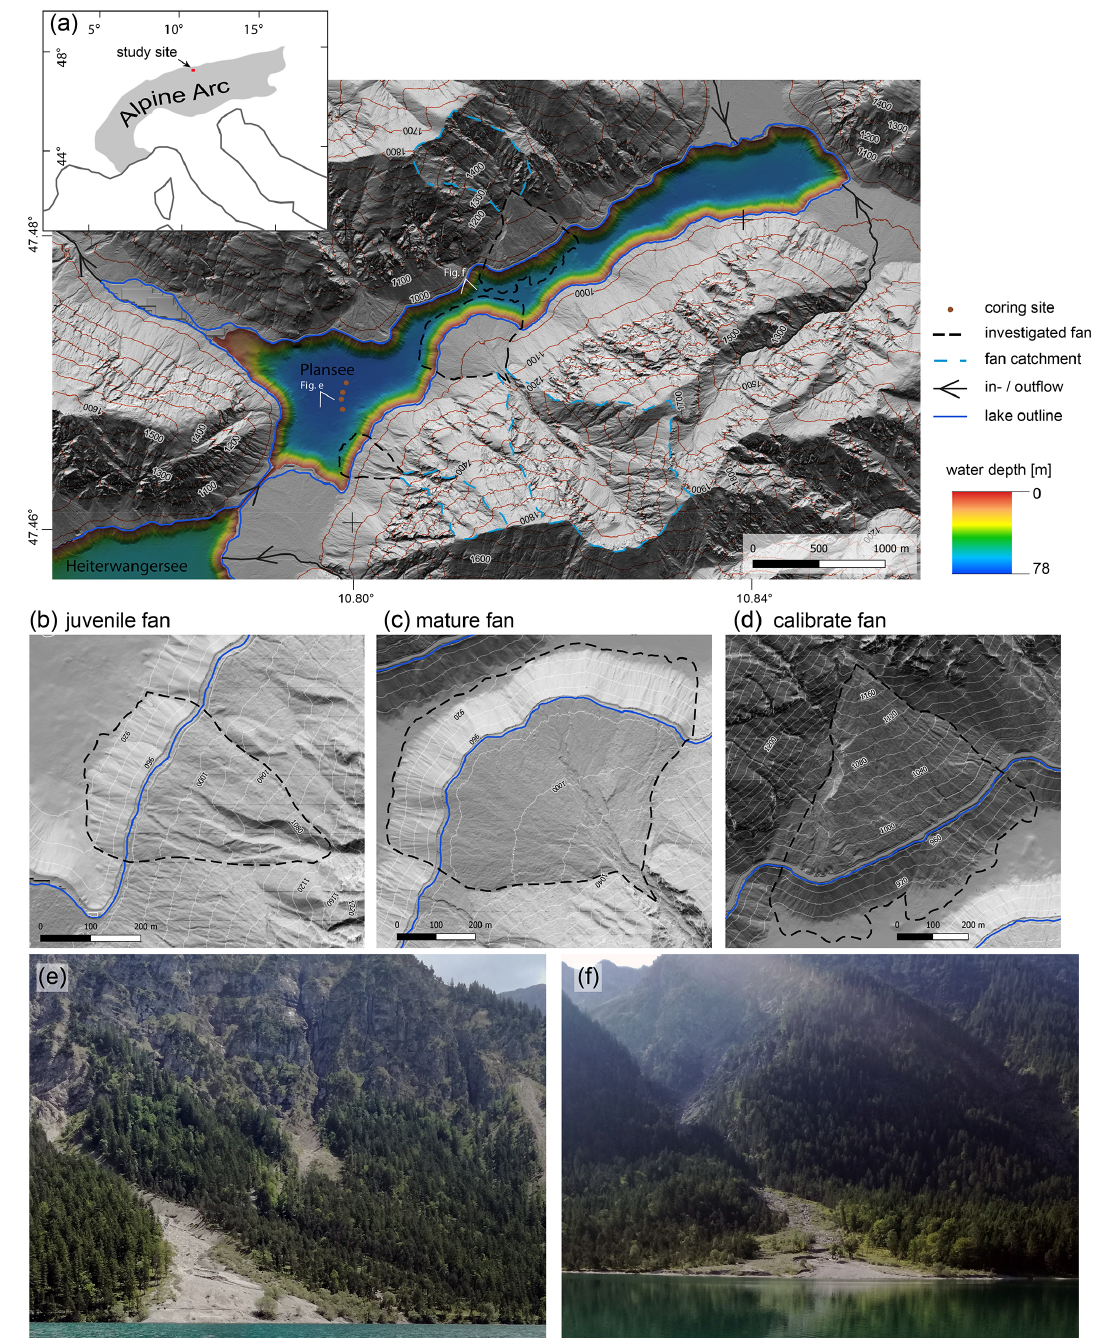
Figure 1. Overview map of Plansee and the investigated alluvial fan deltas. (a) Bathymetry of Plansee highlighting the investigated fan deltas (dashed black lines) with their catchments (blue dashed lines) and coring sites (red dots) used for the characterization of subaquatic debris flow turbidites. The upper left inlet indicates the location of Plansee within the Alpine arc. Hill shading of combined DEM and bathymetry of (b) the small and steep juvenile fan, (c) the large and low-angle mature fan, and (d) average-sized fan delta with documented debris flow activity in 1947–2014CE (Dietrich and Krautblatter, 2017) that were used for the characterization of geomorphic features. The juvenile (b, e) and mature (c, f) fans were repeatedly investigated by terrestrial laser scan measurements in 2019 (see Figs. 4 and 5). Onshore DEM is derived from Land Tirol (https://data.tirol.gv.at, last access: 31 January 2021).